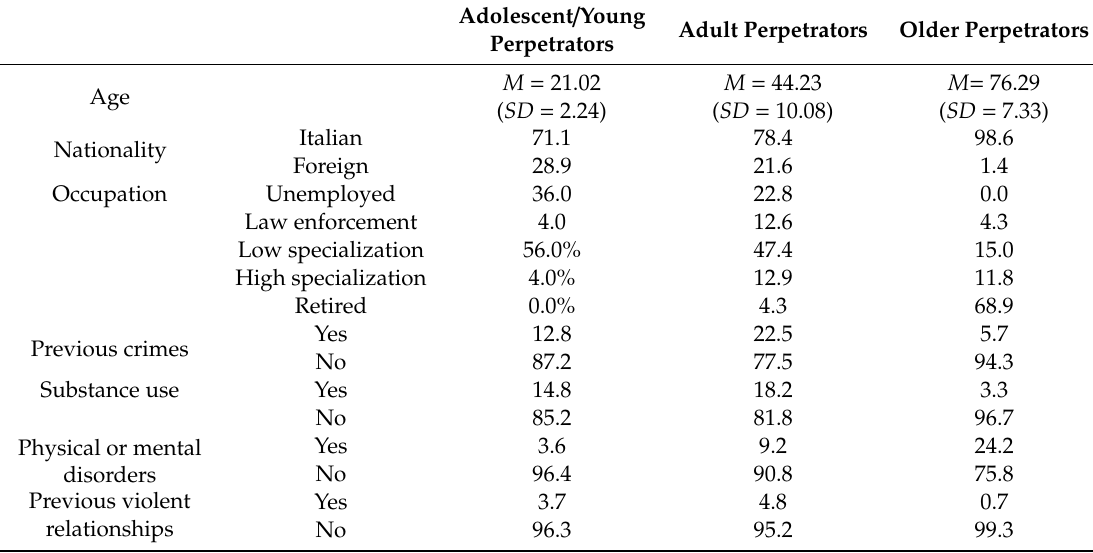
Table 2. Descriptive statistics for perpetrators by age